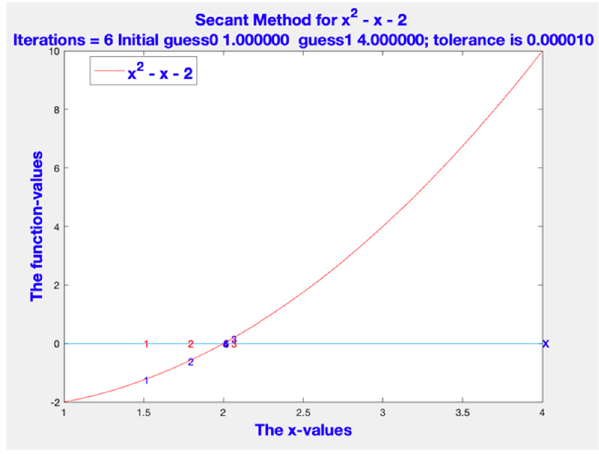
Figure 9. Plot of secant algorithm execution. Table 4. Bisection algorithm, iterations, AppRoot, error and interval bounds.